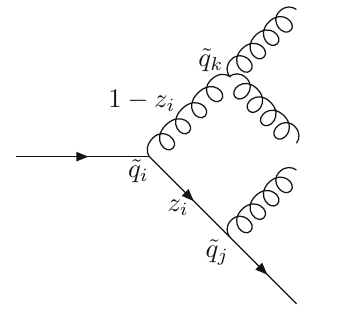
Fig. 1 Branching of parton i to produce partons j , k , which then undergo subsequent